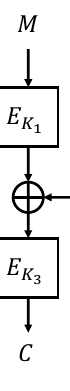
Figure 3: Specification of LRWQ [ E